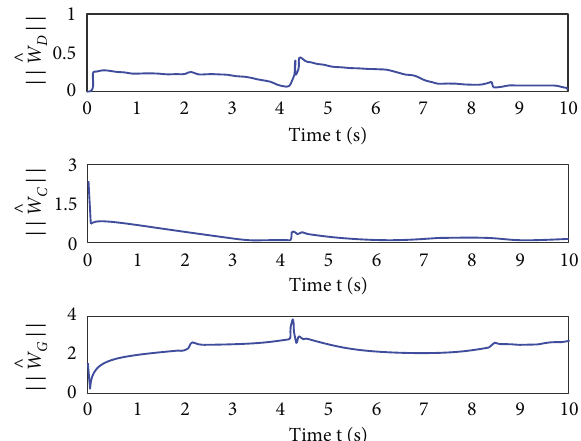
Figure 9: Neural network weight estimation curve for the proposed control scheme.